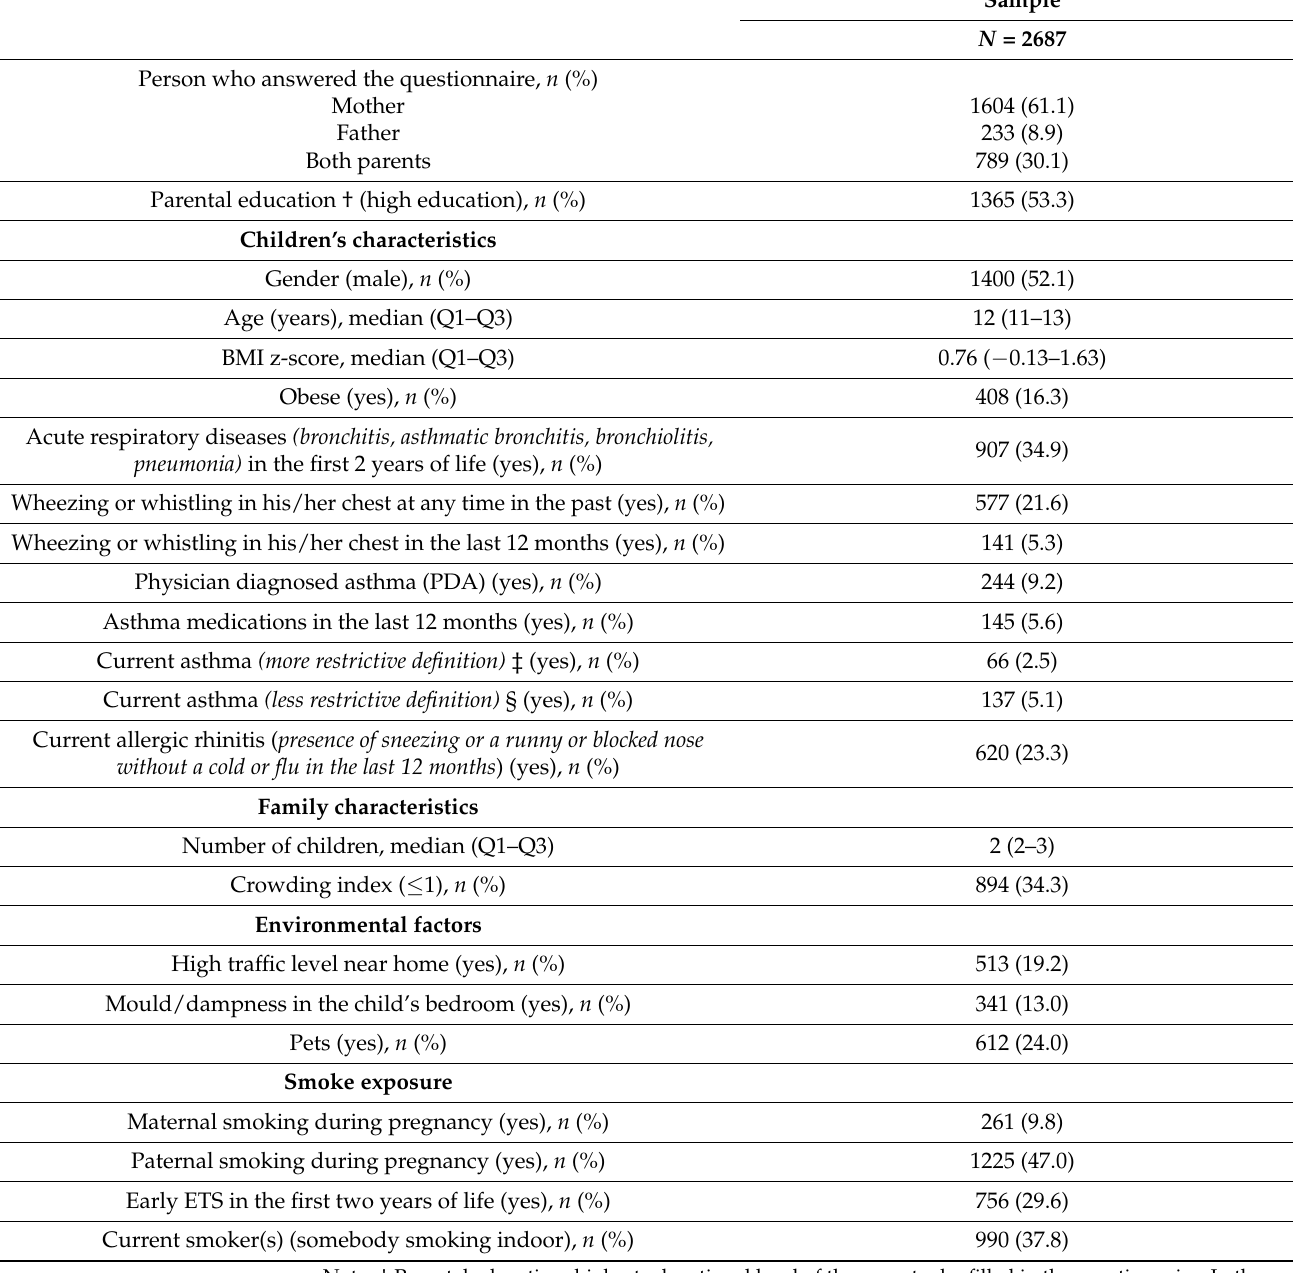
Table 1. Description of the pooled